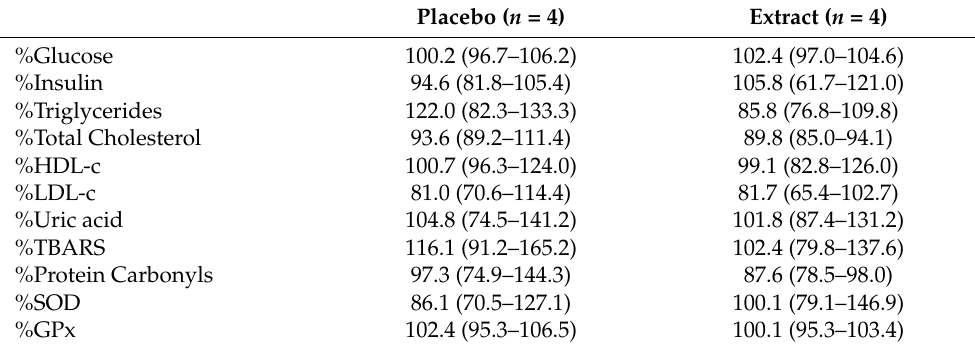
Table 6. Percentage of change in basic biochemical and oxidative stress markers in the two long-term